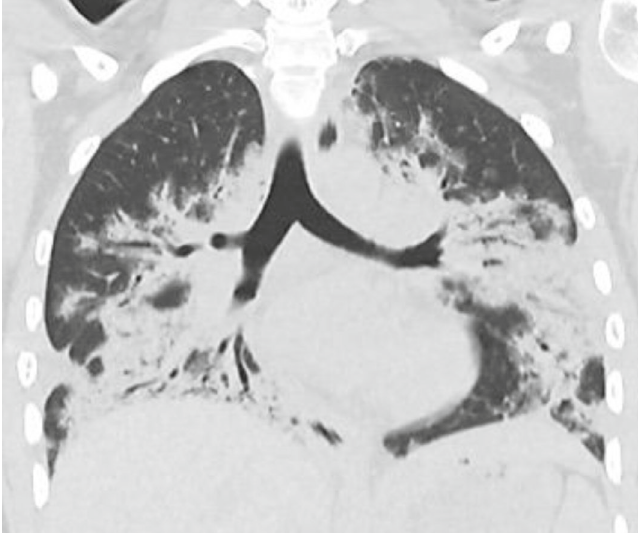
Figure 3: Coronal high-resolution CT image demonstrates extensive bilateral peribronchovascular consolidations with air bronchograms, as well as scattered small nodular opacities.